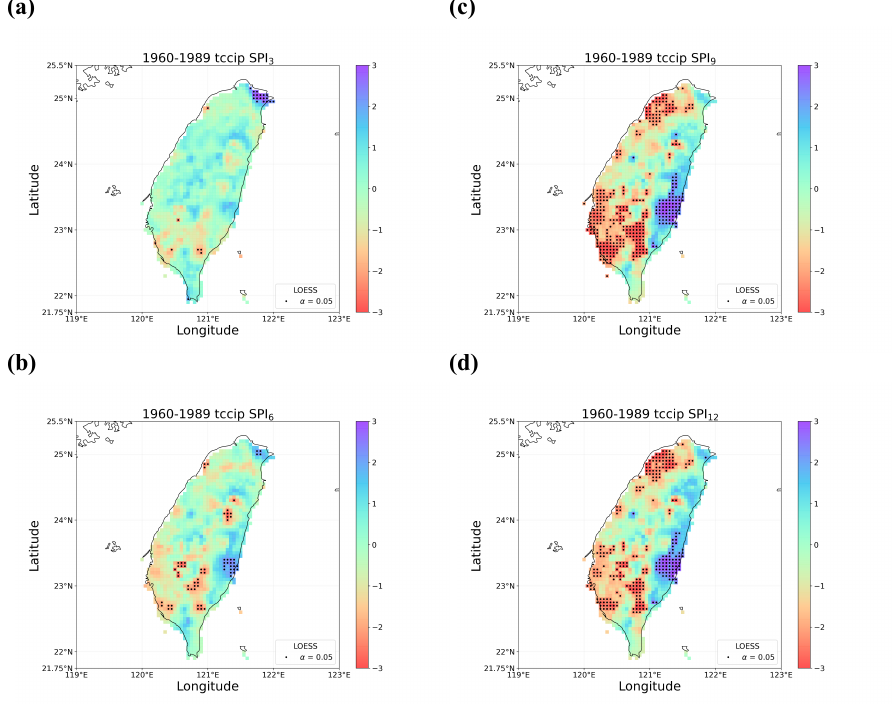
Figure 9. The same as Figure 7, but for detected trends using